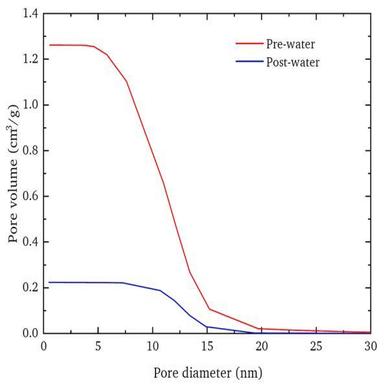
Cumulative BJH PSDs, obtained using a value of k=1 in, for sample of G1 before and after water adsorption to a relative pressure of 0.914.